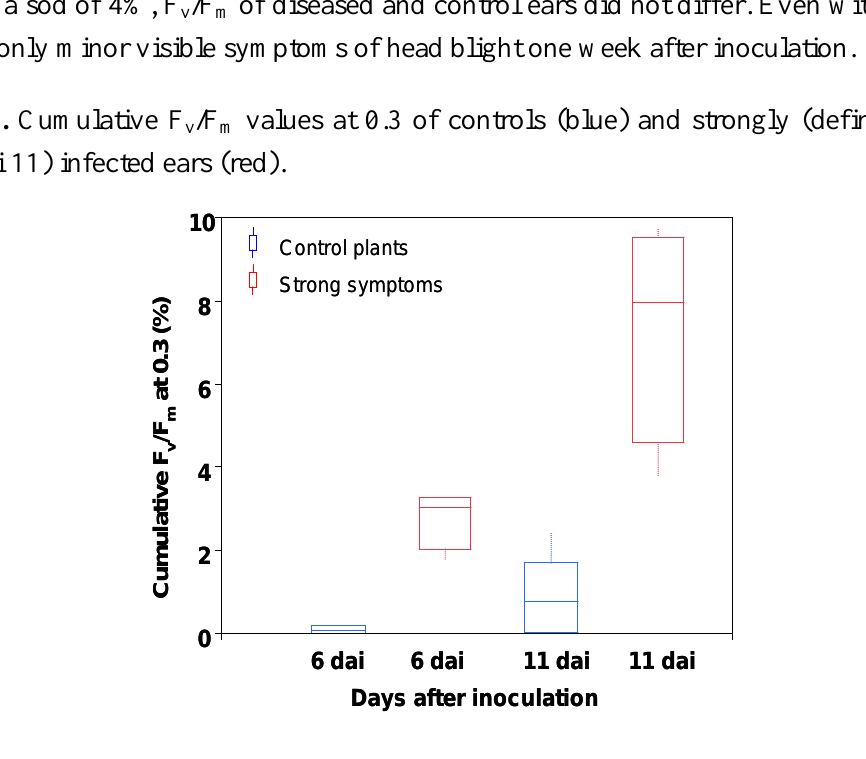
/F values at 0.3 of controls (blue) and strongly (defined as 5% v m